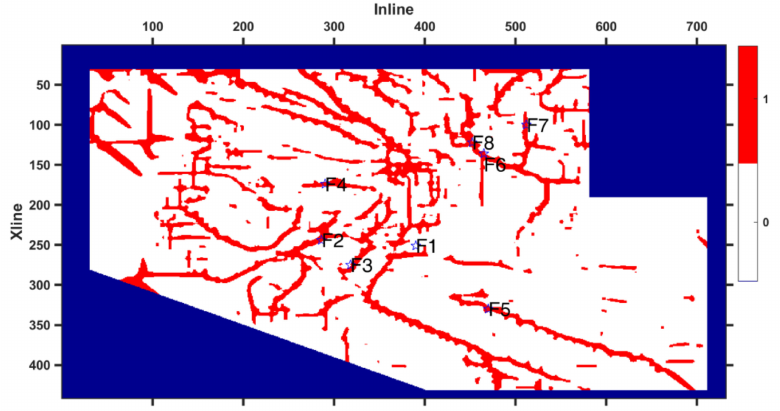
Figure 16. Fault prediction results of the